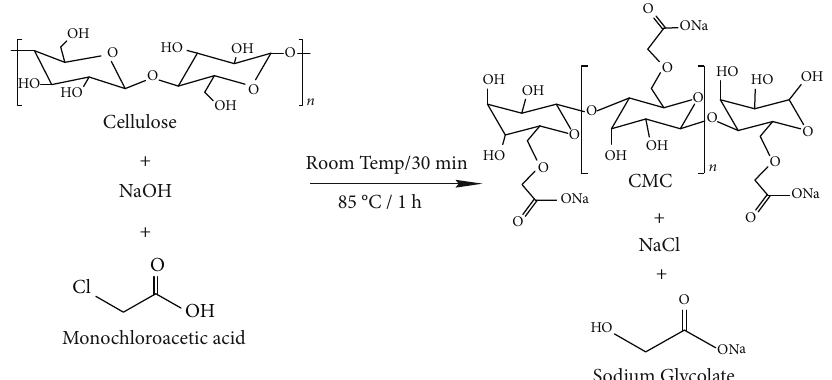
Scheme 2: Reaction mechanism of prepared